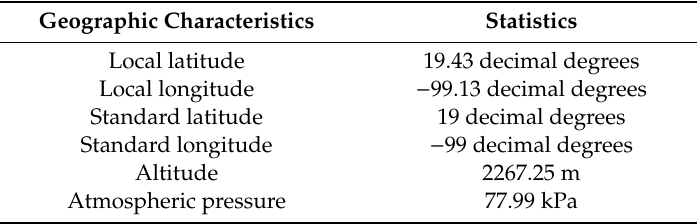
Figure 2. Average atmospheric conditions of Mexico City. ( a ) Ambient temperature, ( b ) Wind speed, ( c ) Normal beam radiation, ( d ) Relative humidity. Table 2. Geographic characteristics of Mexico City.